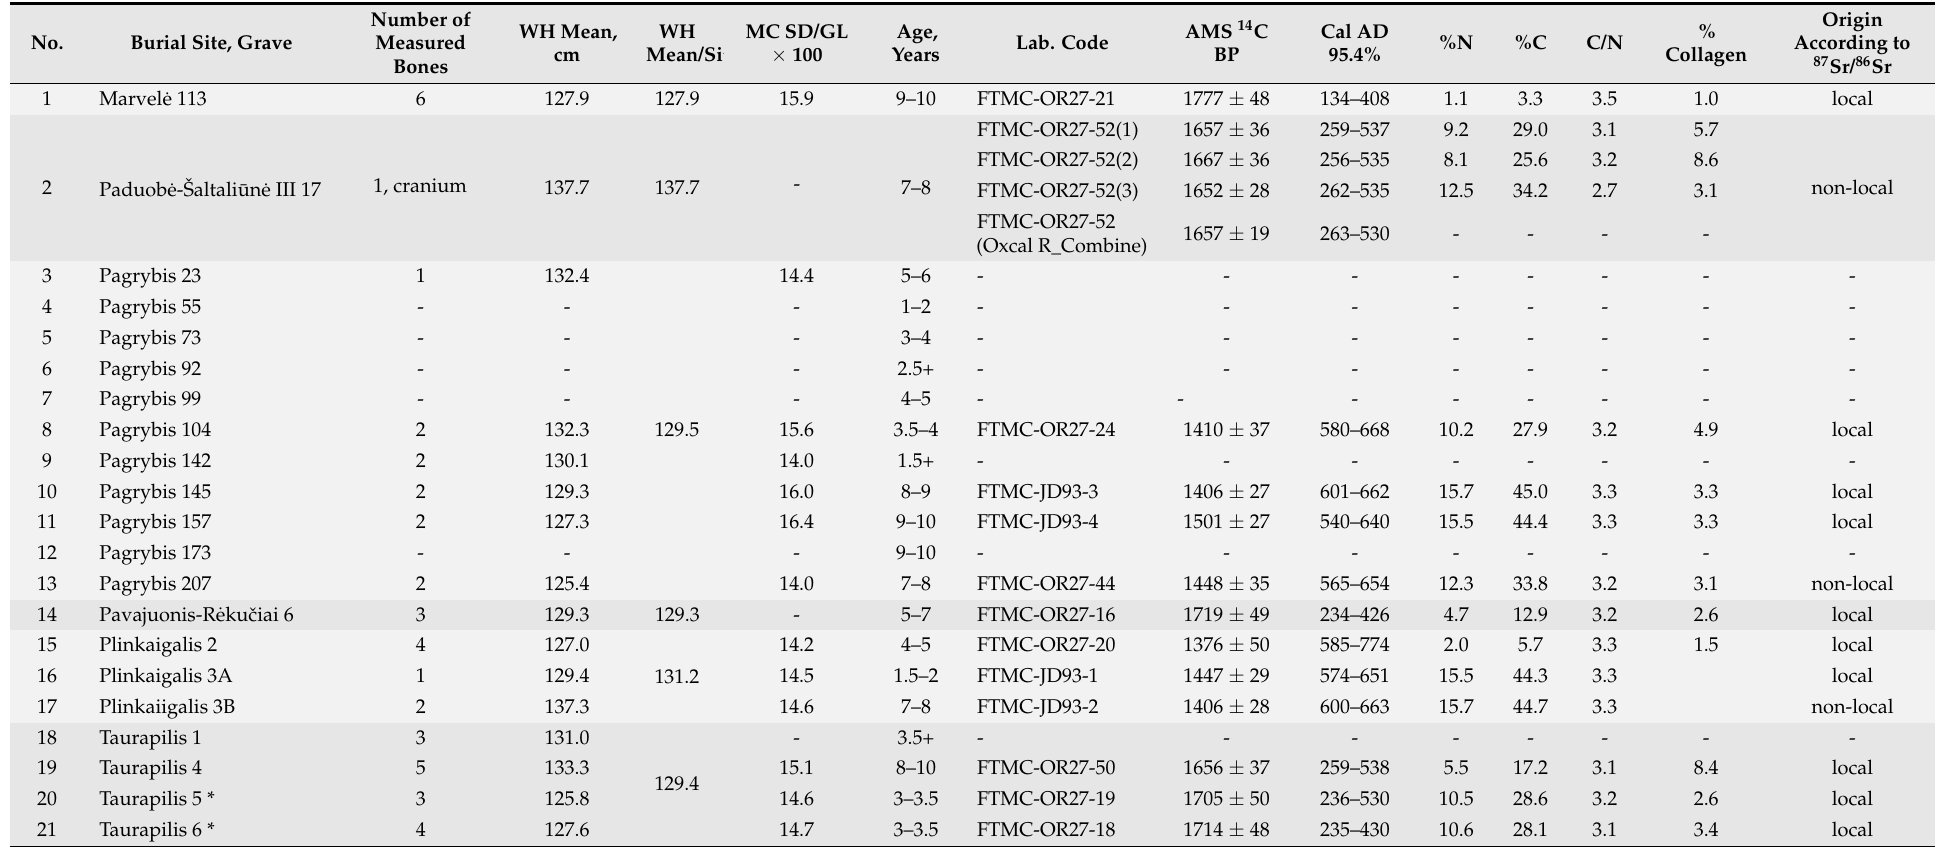
Table 1. The Late Roman–post-Migration period horses studied. Reference for 87 Sr/ 86 Sr data Ref. [29]. * Bones whose epiphyses had not yet fully fused were also